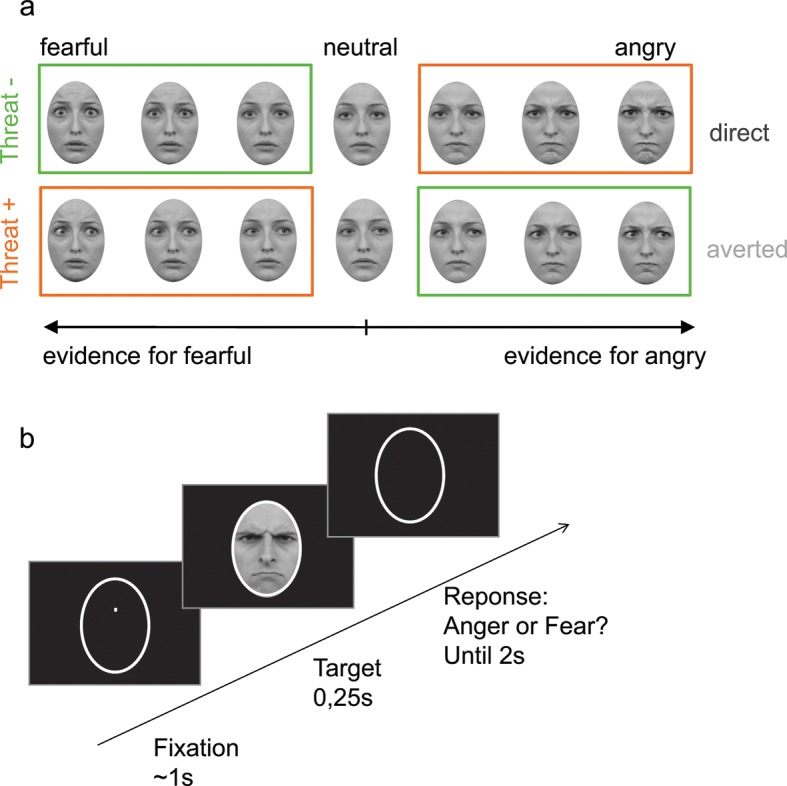
Stimuli and experimental procedure.(a) Examples of morphed expressions for one identity: morphs from neutral to intense fearful/angry expressions providing evidence for one or the other emotion. Stimuli displayed either an averted or a direct gaze. THREAT+ conditions (in orange) correspond to combinations of gaze and emotion that signal higher threat for the observer as compared to THREAT− conditions (in green). (b) Following fixation, a facial expression appeared for 250 ms, after which the participant had to indicate whether the face expressed anger or fear within 2 seconds. No feedback was provided after response.